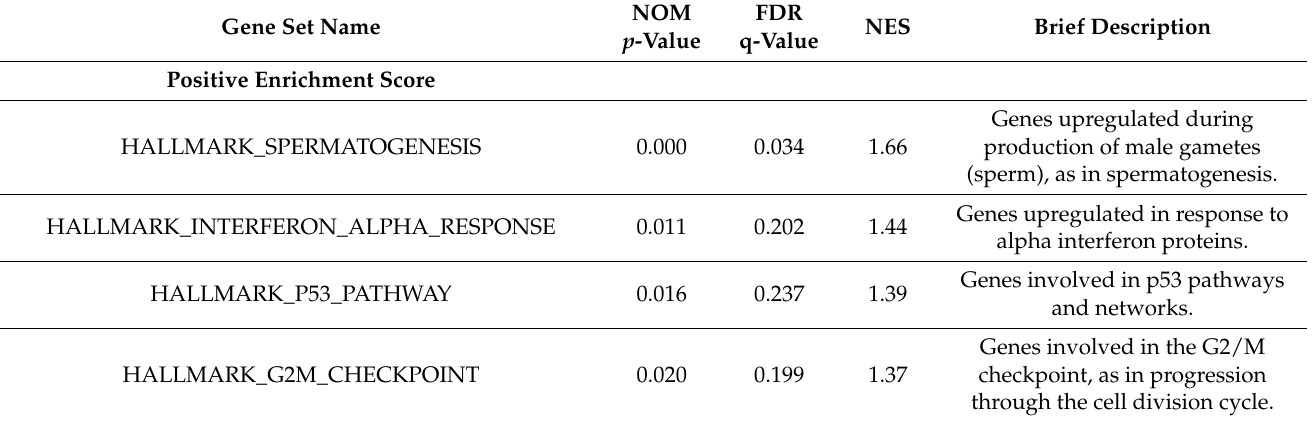
Table 3. Gene set enrichment analysis of transcriptional differences in whole blood associated with mortality in community-acquired